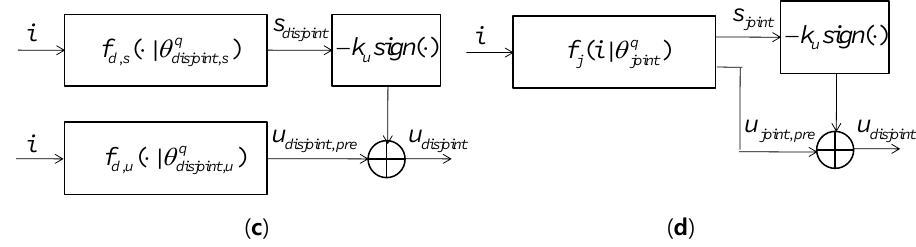
Figure 1. The structure of the proposed DL-based consensus control ( a ) baseline DL; ( b ) sequential DL; ( c ) disjoint DL; ( d ) joint DL.